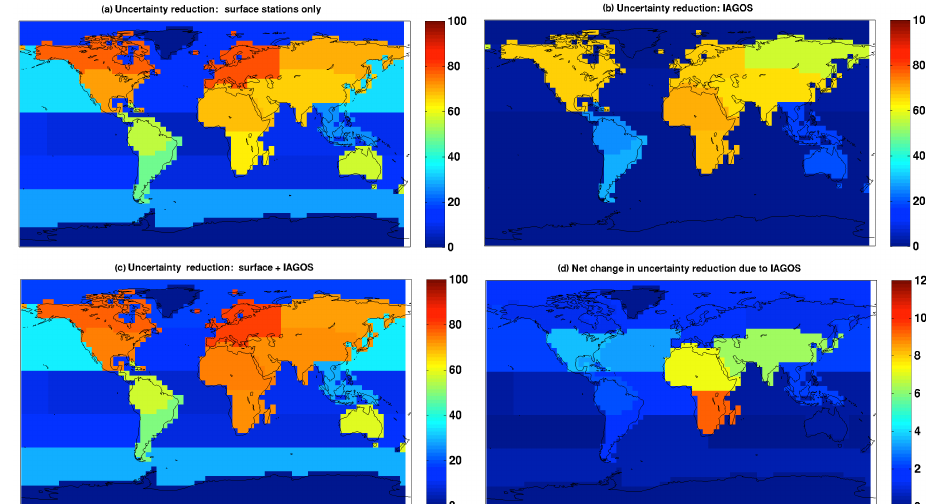
Figure 5. Spatial maps showing the reduction in monthly CO 2 flux uncertainty (in percent) at the TransCom3 regions during the period 1996– 2004 using measurements from (a) the Surface network alone, (b) five simulated IAGOS aircraft and (c) combined network (surface + IAGOS aircraft). Panel (d) shows the net change in uncertainty reduction due to the addition of IAGOS measurements to the surface